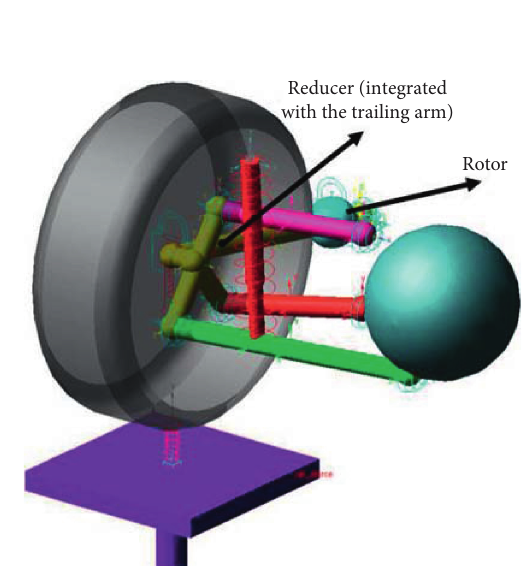
Figure 5: Dynamics model of the integrated E-type multilink suspension wheel-side drive